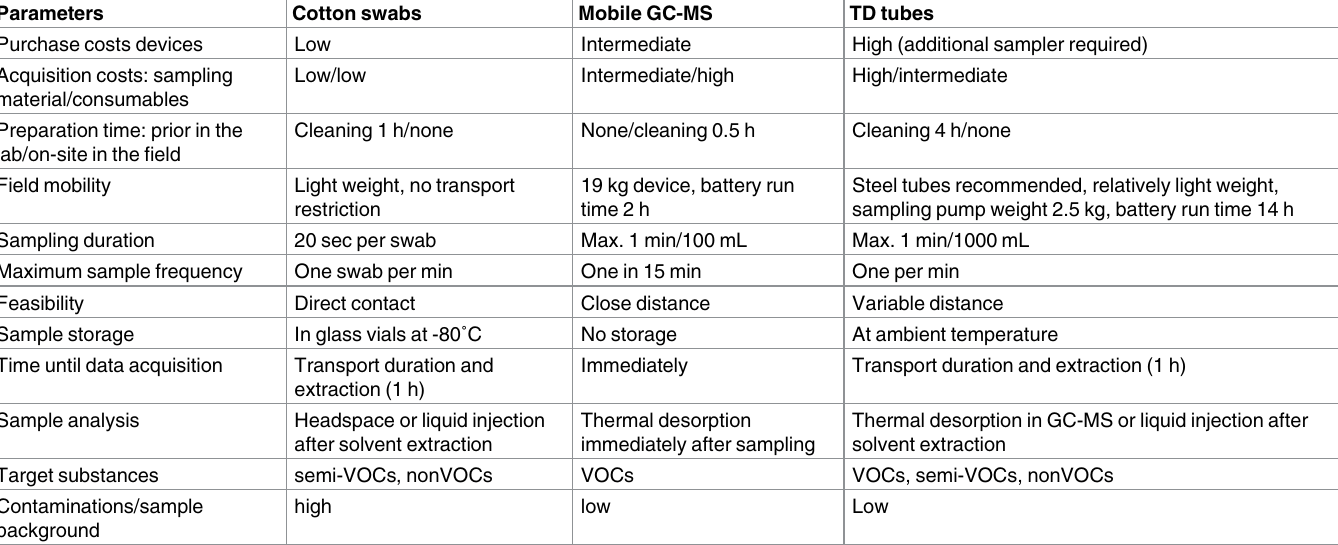
Table 4. Comparison of key properties influencing the feasibility of the sampling